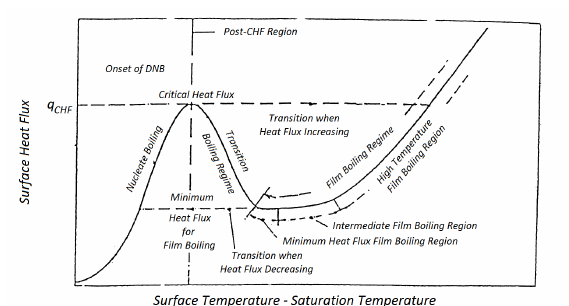
Figure 1. Typical boiling curve